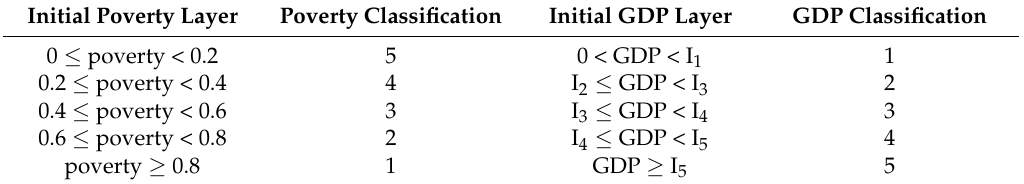
Table A6. Re-classification of GDP and poverty layers into five classes. I 1–5 are the geometric intervals of the classification process.